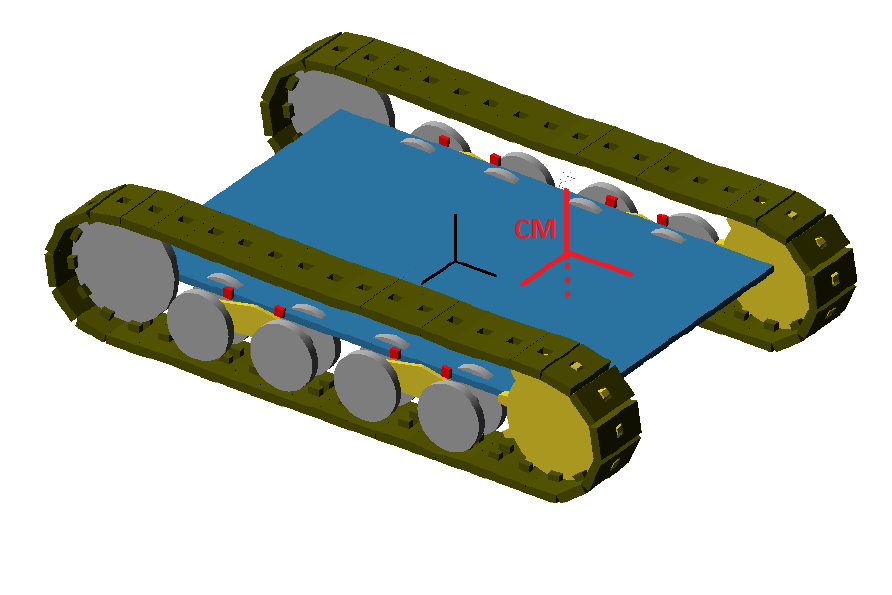
Figure 6. Complete model of the farming